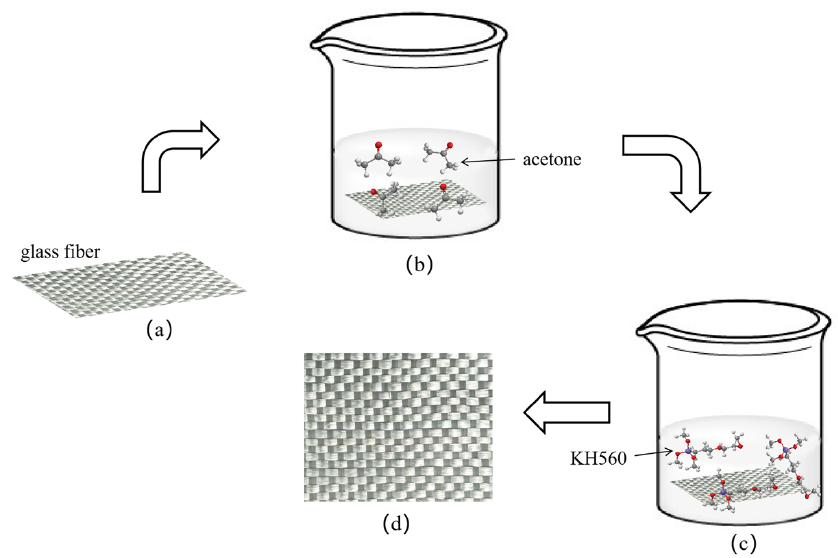
Figure 1. Reaction process. ( a ) Glass fiber before modification ( b ) Acetone treatment ( c ) Silane coupling agent treatment ( d ) Modified glass fiber.